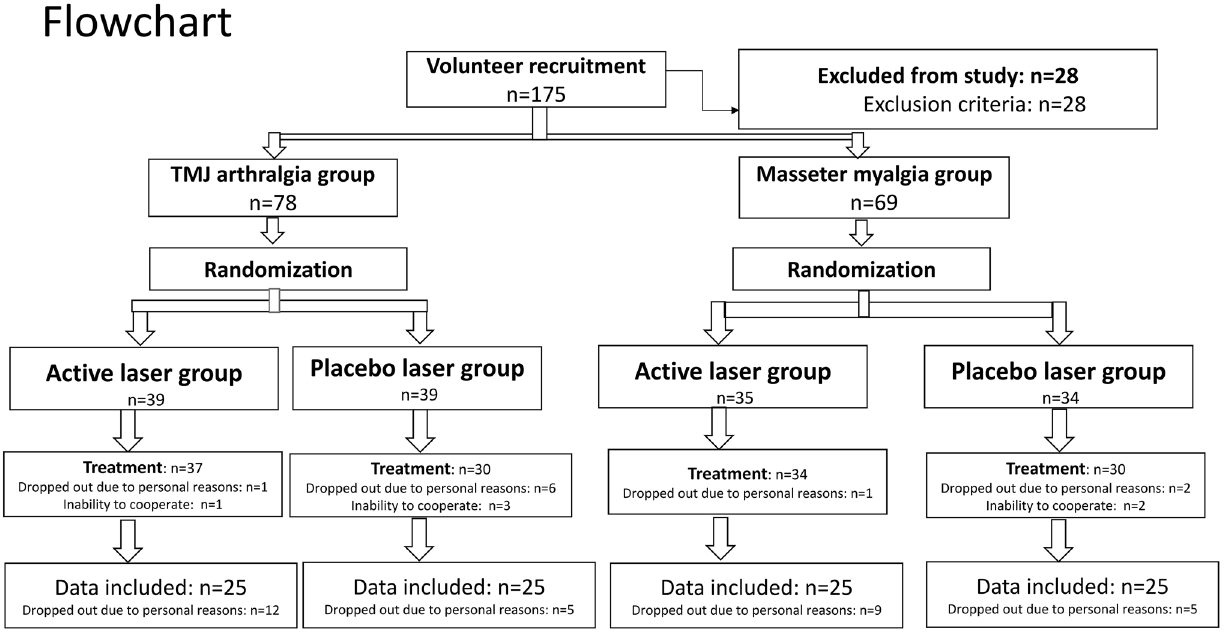
Figure 1. Flow chart of study. Personal reasons: include lack of time, work problem or reluctance to continue the